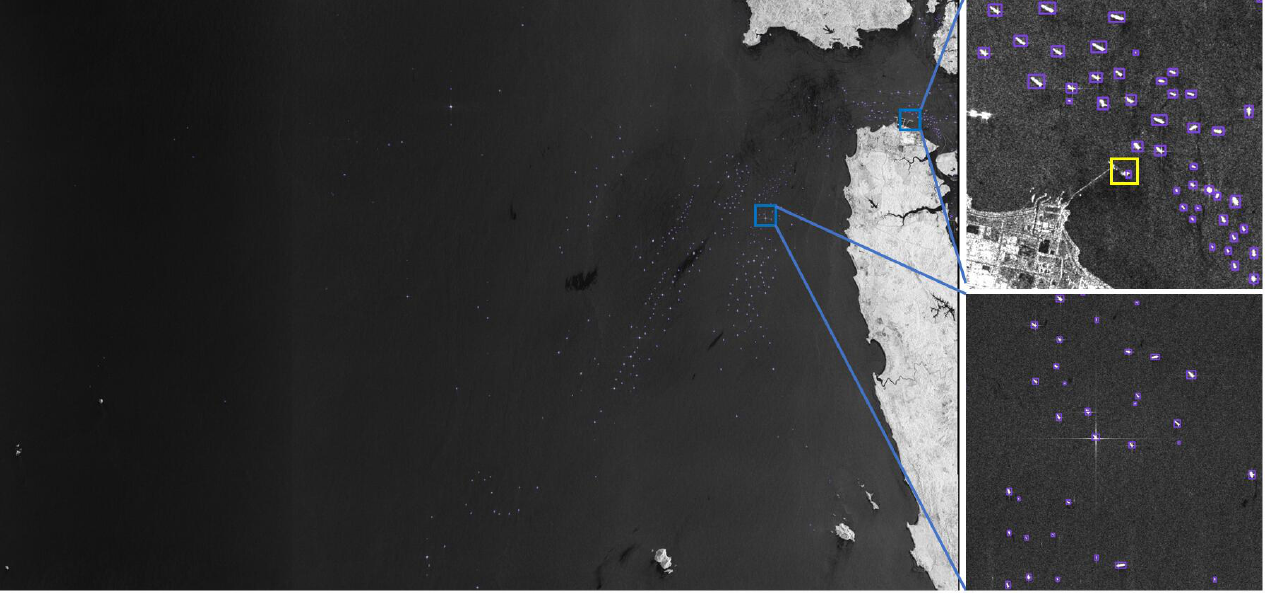
Figure 23. The visualized SAR ship detection result on Image 2. Table 8. The experimental results of different methods on the two large-scene SAR